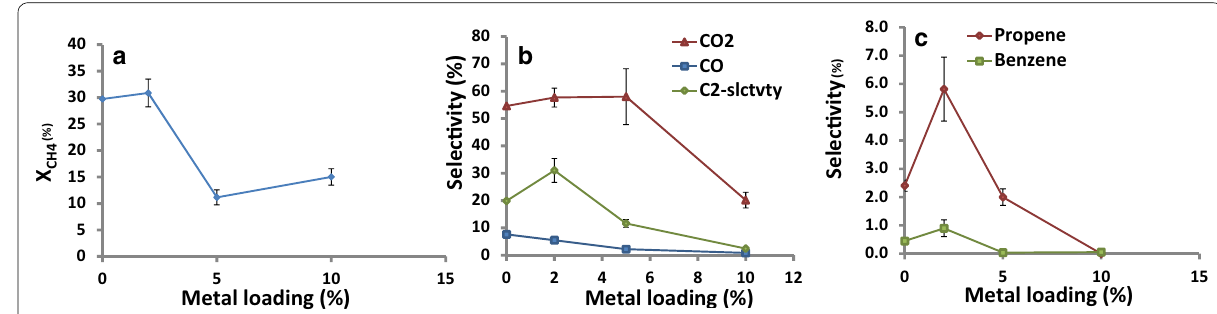
Fig. 3 Effect of iron loading (wt%) on ( a ) conversion of methane, ( b ) yield of C 2 hydrocarbons and carbon oxides, ( c ) yield of C 3 –C 6 hydrocarbons under the experimental conditions: 650 ºC, 0.8 L/min, 10 g catalyst and CH 4 :O 2